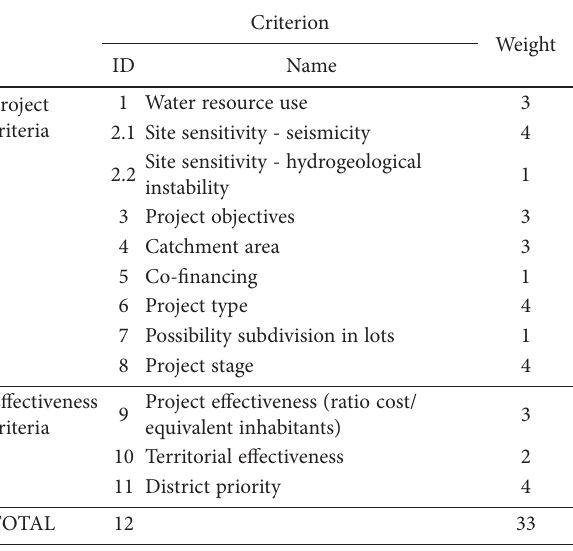
Table 1. Criteria and their assigned weights .